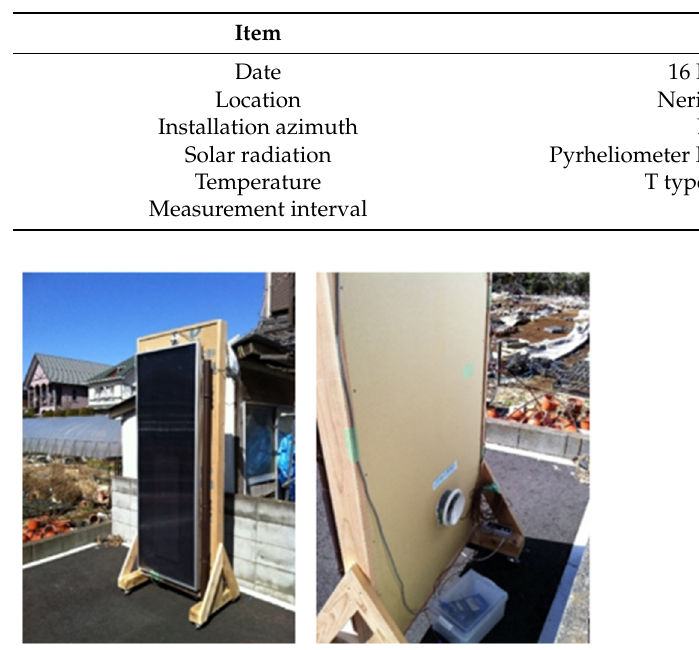
Table 2. Outline of experiment.